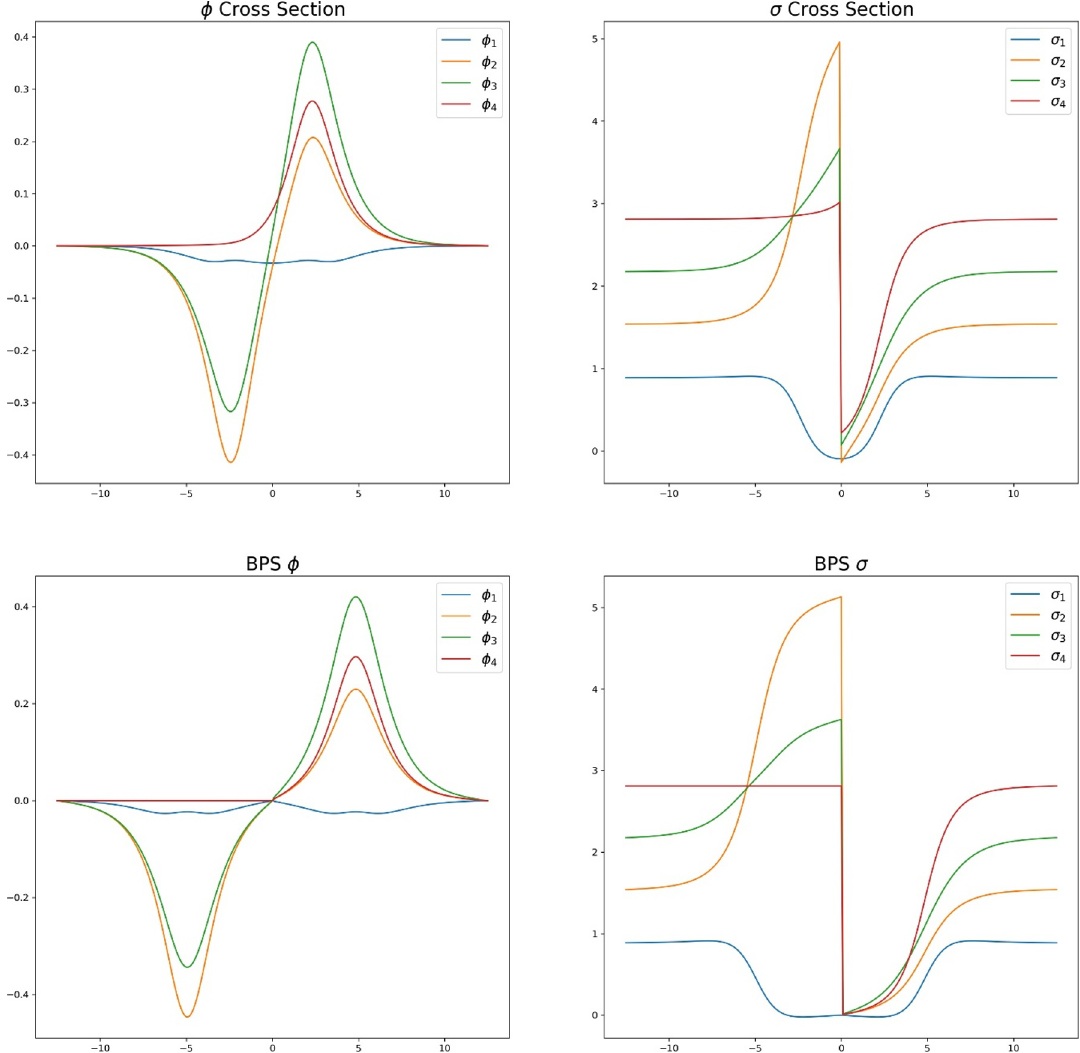
Figure 6. Comparison of the y = 0 (the midpoint between the quarks) cross section (top row) of the double string of figure 5 with a corresponding pair of BPS solutions (bottom row). The fact that the quarks are far away from this location implies that the top and bottom plots ought to match. On the bottom plot, the 1D equations for two BPS DWs are separately solved and then cut and pasted together at a distance ∆ z ∼ 10 . However, the separation of the kinks of the cross section in the 2D solution is a consequence of the physics of string separation (see section